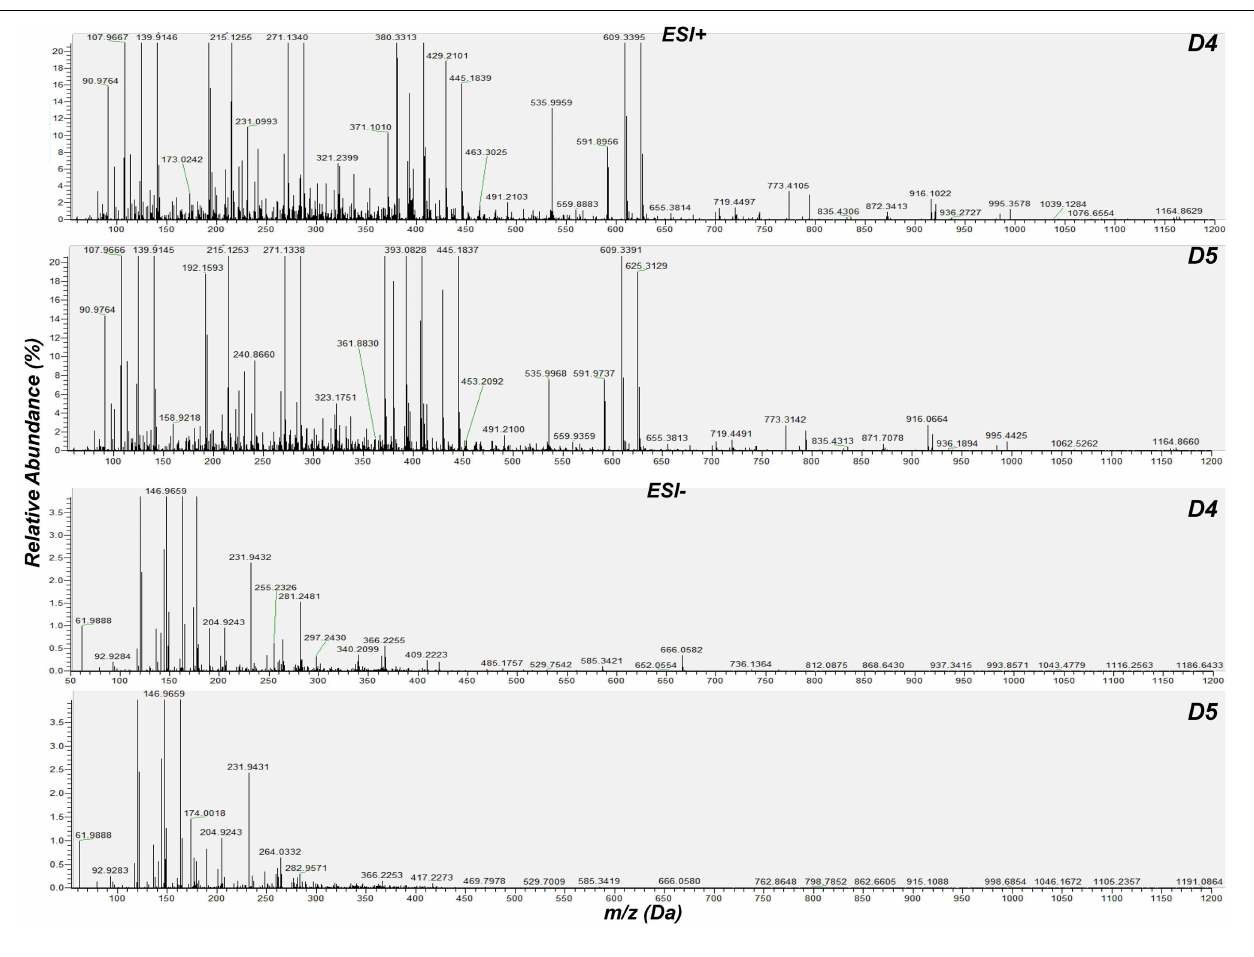
modes performing direct infusion analysis in the range 50–1200 Da. The software Xcalibur 2.2 was used for the creation of mass spectra.